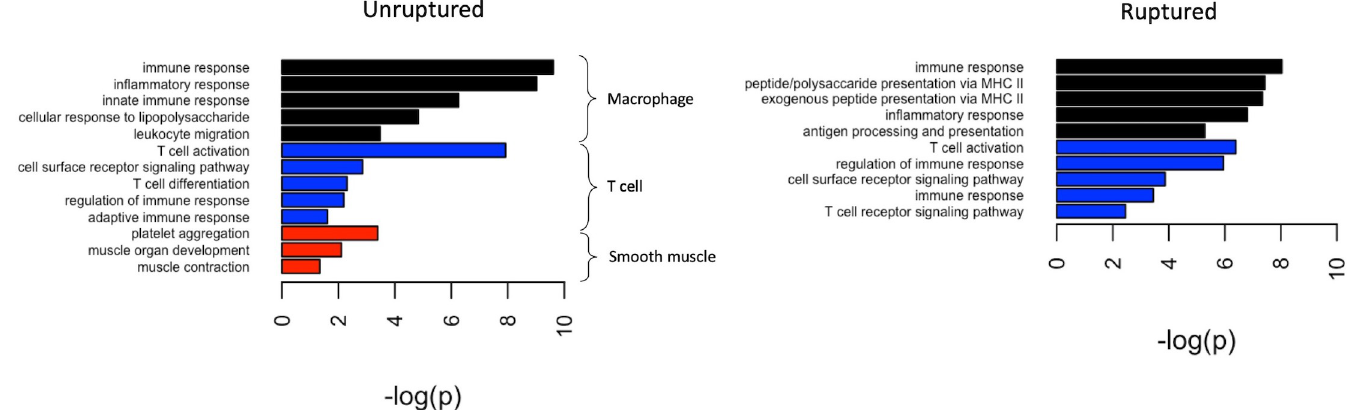
Fig 2. PSEA genes map to expected biological processes in DAVID. Barplots of the top 5 biological processes from each reference cell type, ranked by Bonferroni p- value. Endothelial and mast cell references did not yield any significant annotations in either cohort.